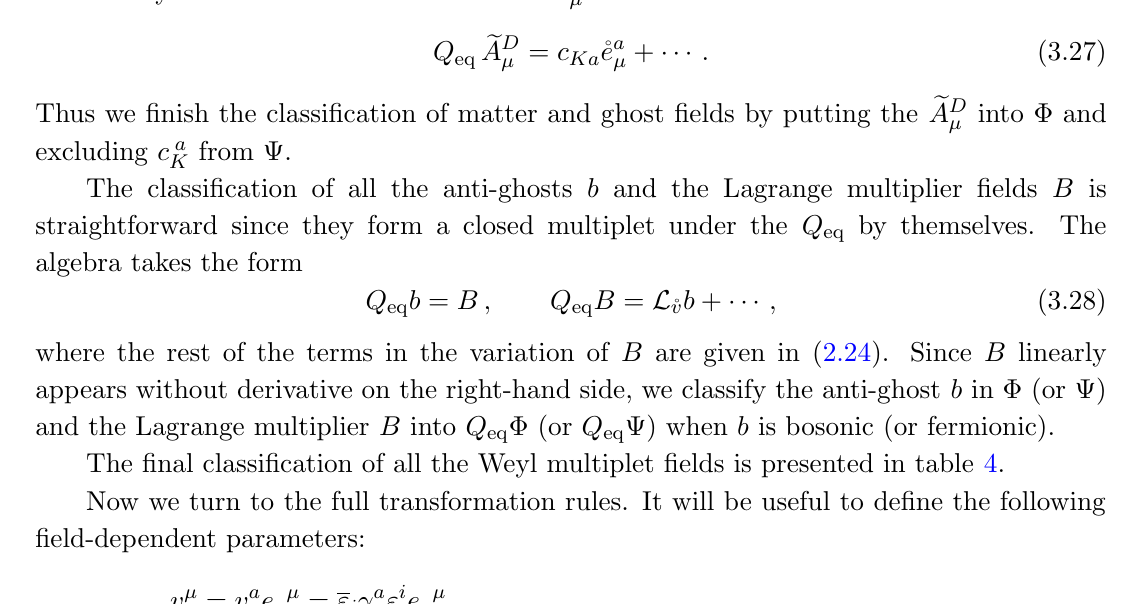
refers appropriate combination of e T + ab